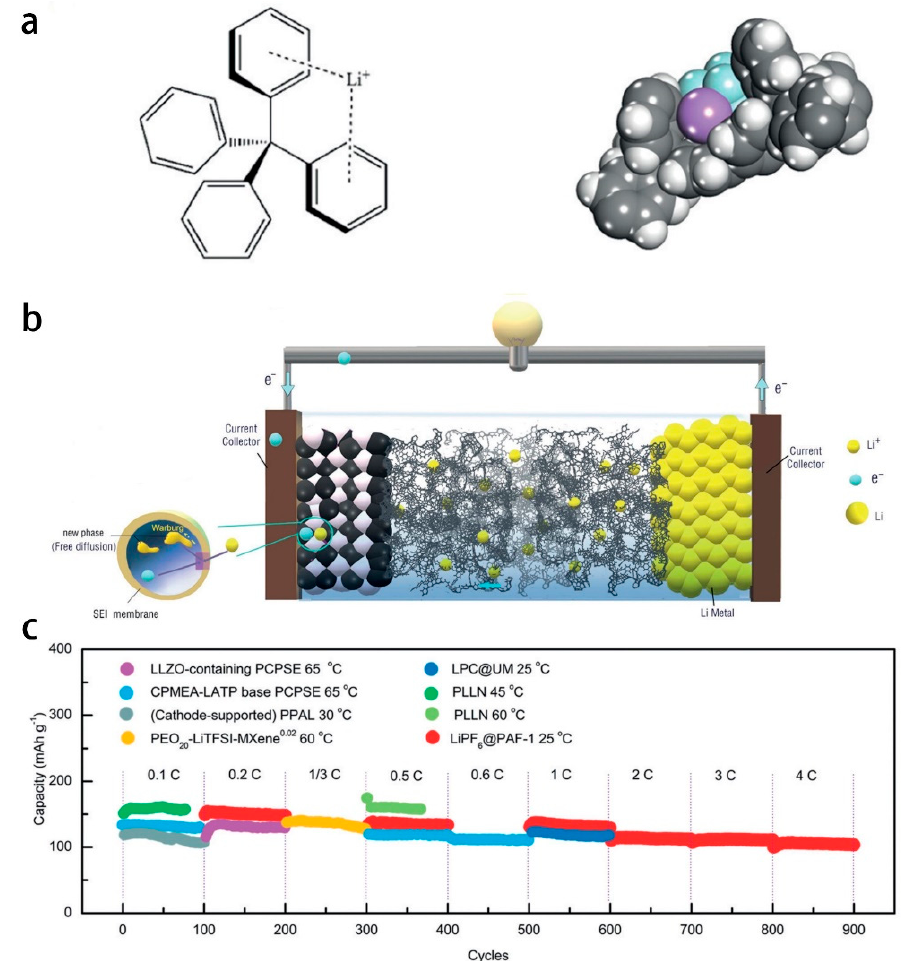
Figure 4. ( a ) Schematic showing the interaction of the Li + ion with the faces of the two phenyl rings of the tetra phenyl methane nodes of PAF − 1 and the van der Waals radius of each respective atom, Li ions are colored purple while F, P, C, and H atoms are colored light blue, pink, grey and white, respectively. ( b ) Mechanism of operation of the LiFePO 4 //LiPF 6 @PAF-1//Li cell. ( c ) Cycling performance of Li/LiFePO 4 cells with other SSEs and LiPF 6 @PAF − 1 in long term cycles (first 100 cycles). Adapted with permission from ref. [29]. Copyright 2019 John Wiley and Sons.